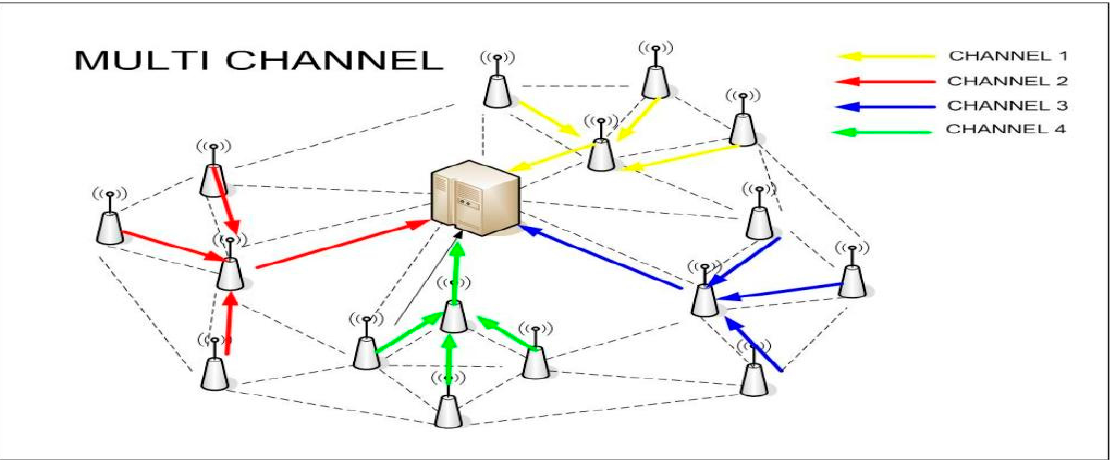
Figure 7. Multi-channel clustering hierarchy (MCCH).